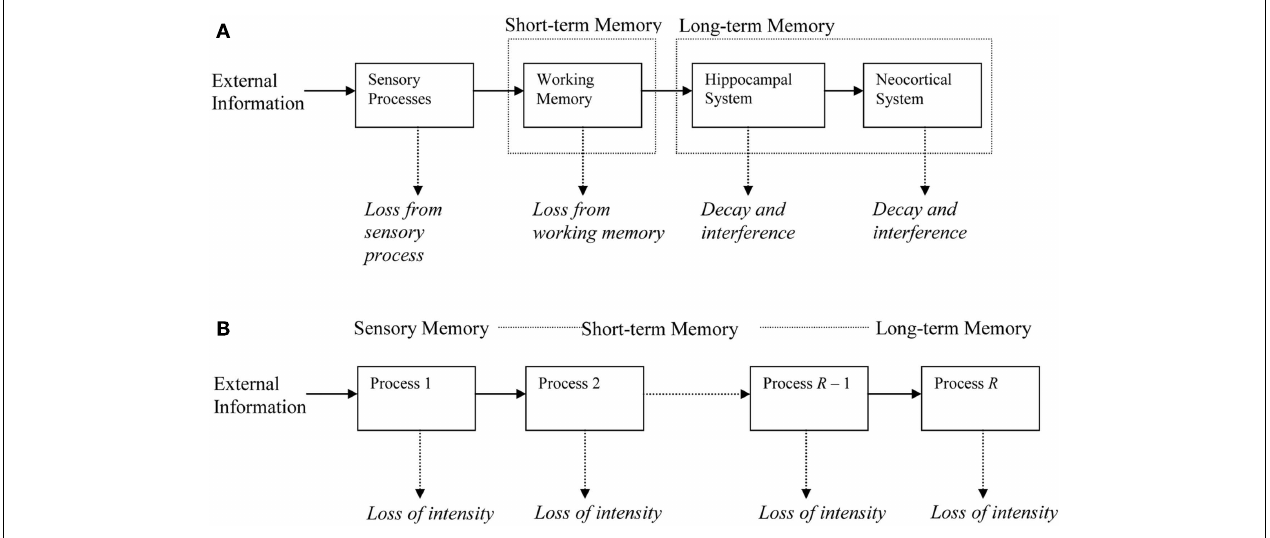
FIGURE 1 | Illustration of the memory chain. (A) Memory systems at different time scales, with memory decline in each system and induction (generation) of new representations in the next system. (B) Abstract representation used in the Memory Chain